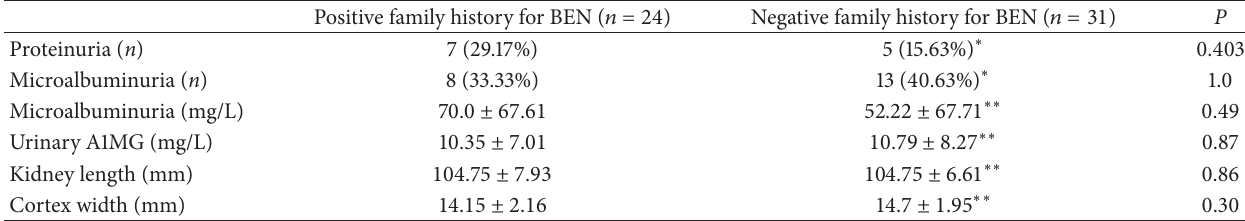
Table 2: Proteinuria, microalbuminuria, A1MG, and kidney size in the examined